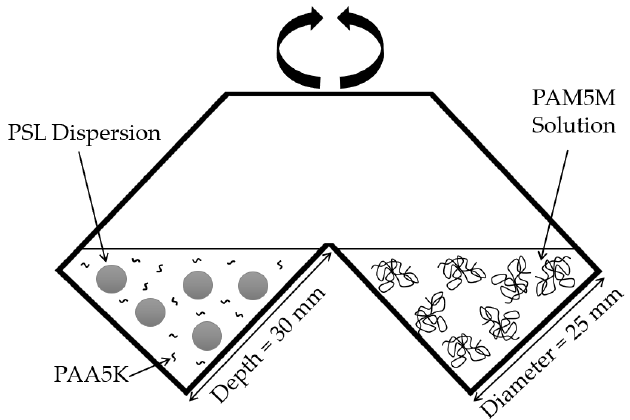
Figure 3. Schematic diagram of the employed end-over-end rotation shaker.